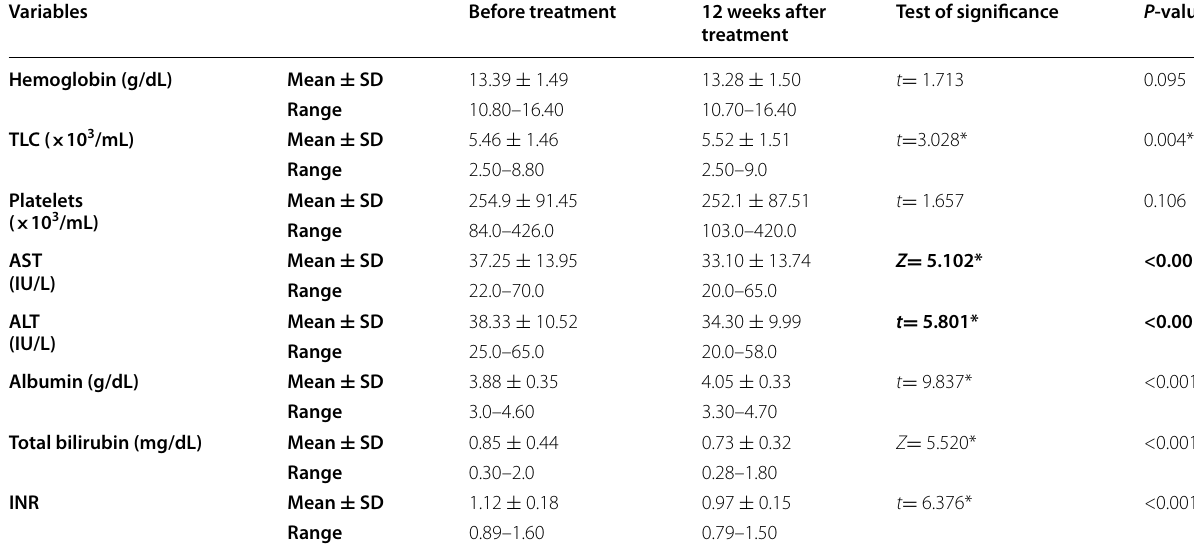
t paired t-test, Z Wilcoxon signed-ranks test, *significant